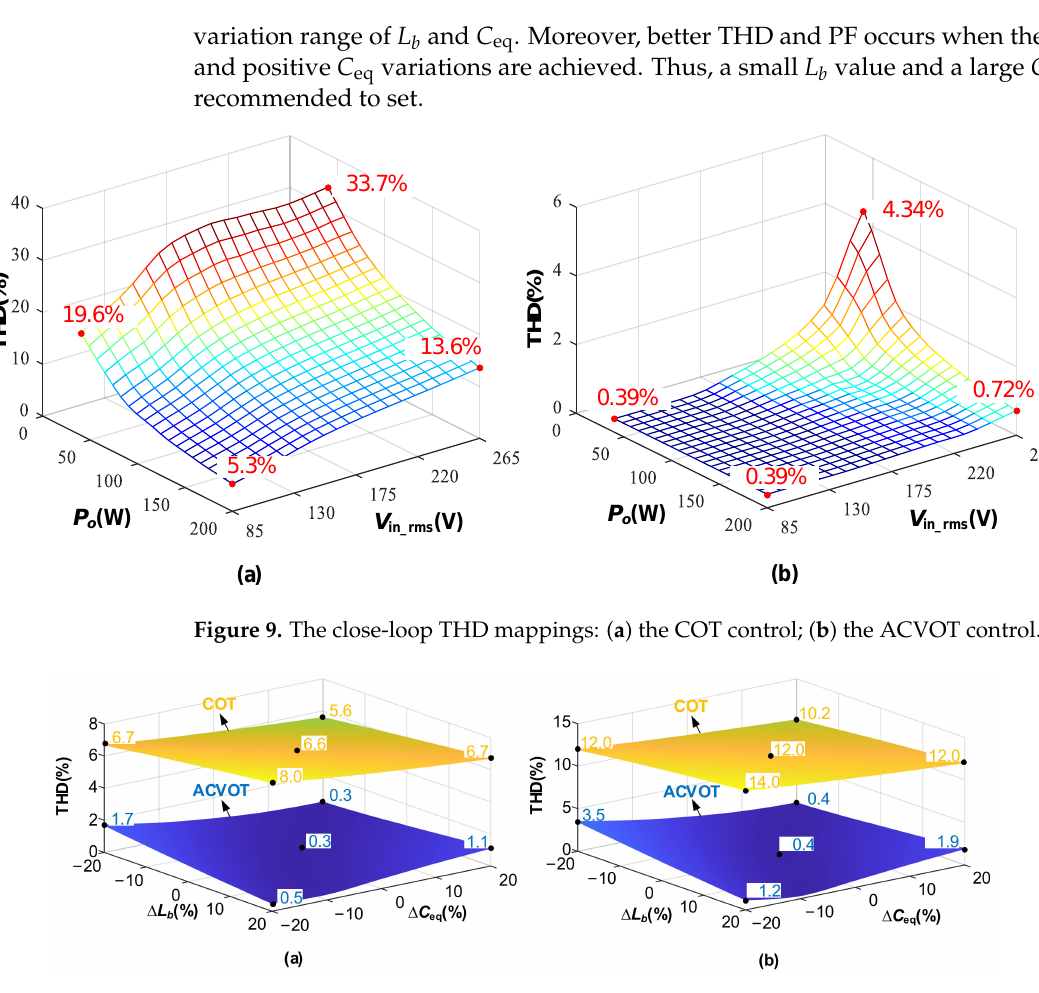
Figure 11. The PF surfaces with L b and C eq deviations: ( a ) 110 Vac; ( b ) 220 Vac.